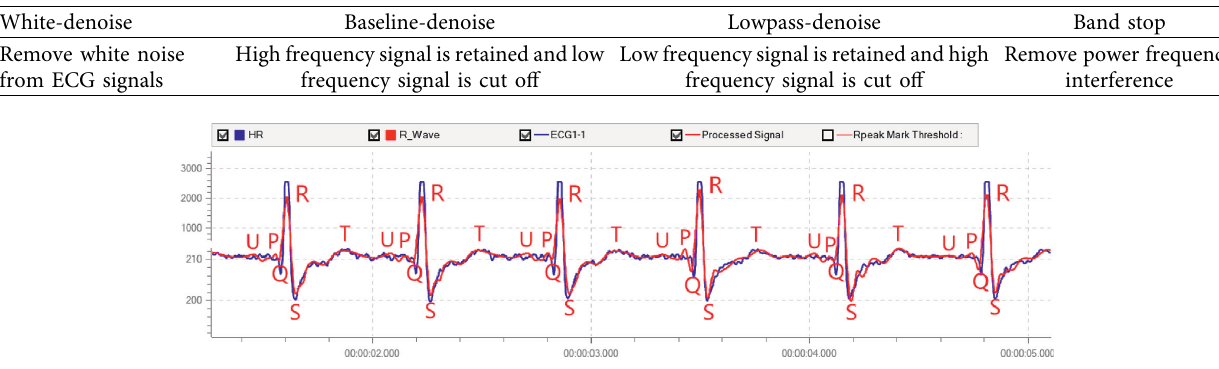
Figure 9: Denoising preprocess interface for original ECG signal. Table 3: The definitions of parameters for denoising preprocess.